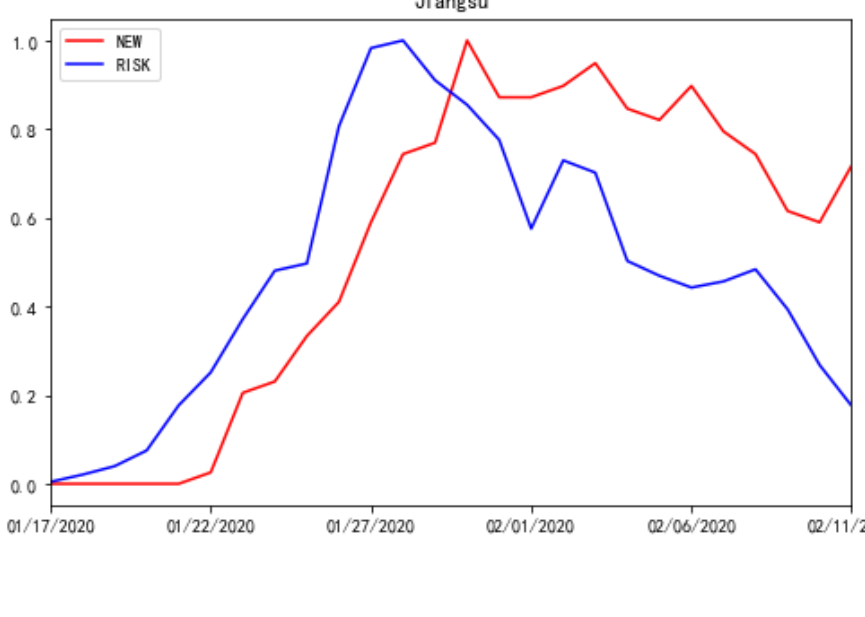
Figure 4. The polyline chart of NEW and RISK for Jiangsu Province from January 17, 2020 to February 11,